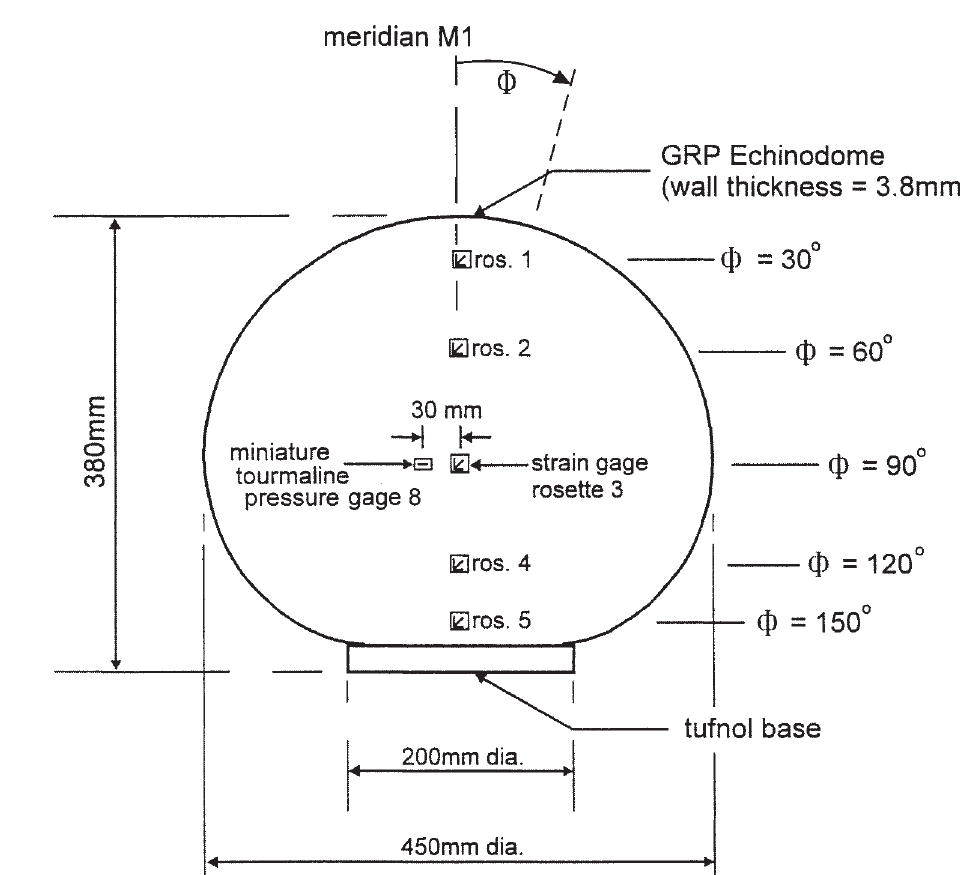
Fig. 2. Disposition of miniature tourmaline pressure gage and strain gage rosettes on shell